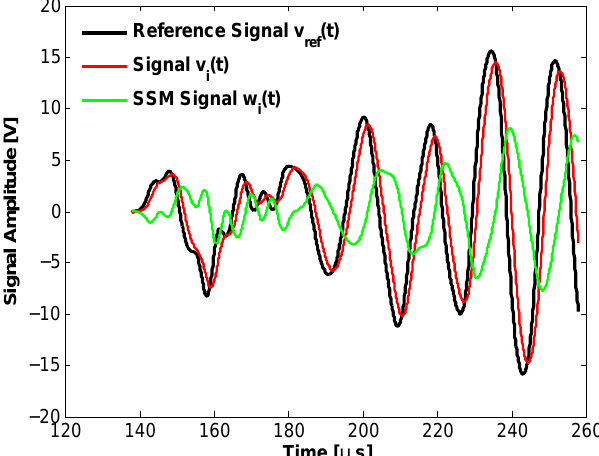
Figure 8. Example of reference signal v r ef ( t ) (black line), detected signal v i ( t ) (red line) and scaled-subtracted signal w i ( t ) (green line) in a short time window close to the first arrivals time. Data refer to a sample at an intermediate level of healing and intermediate excitation amplitude A i = 12 V.